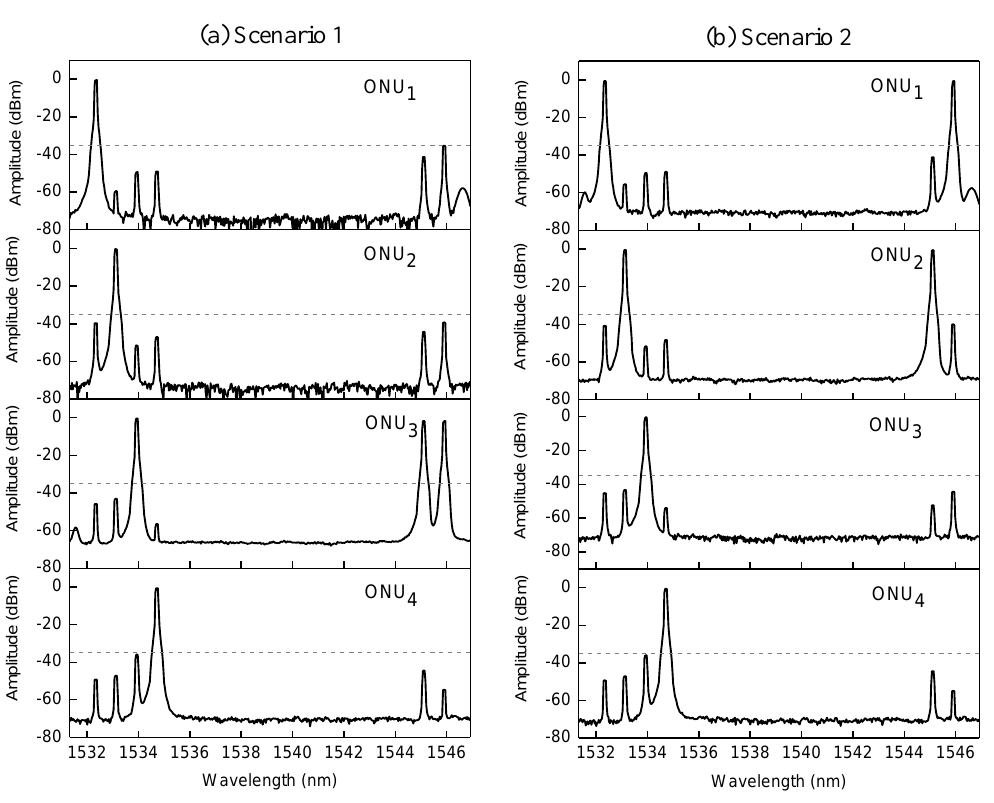
Figure 3. Optical spectra measured at the AWG-RN outputs in downlink direction for ( a ) scenario 1; ( b ) scenario